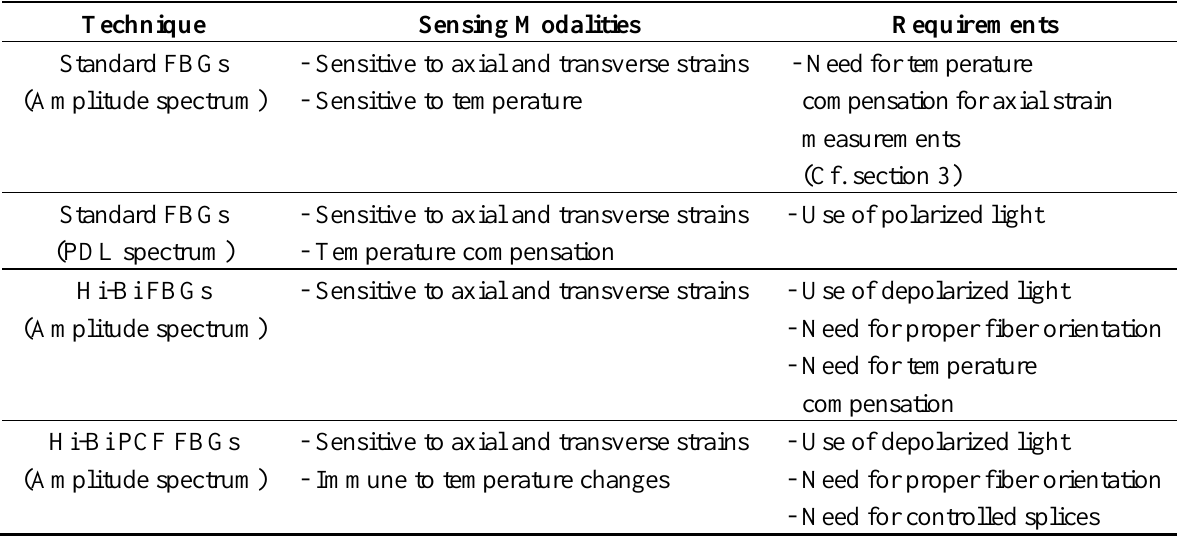
Table 3. Performances of techniques used for strain build-up measurement during the curing